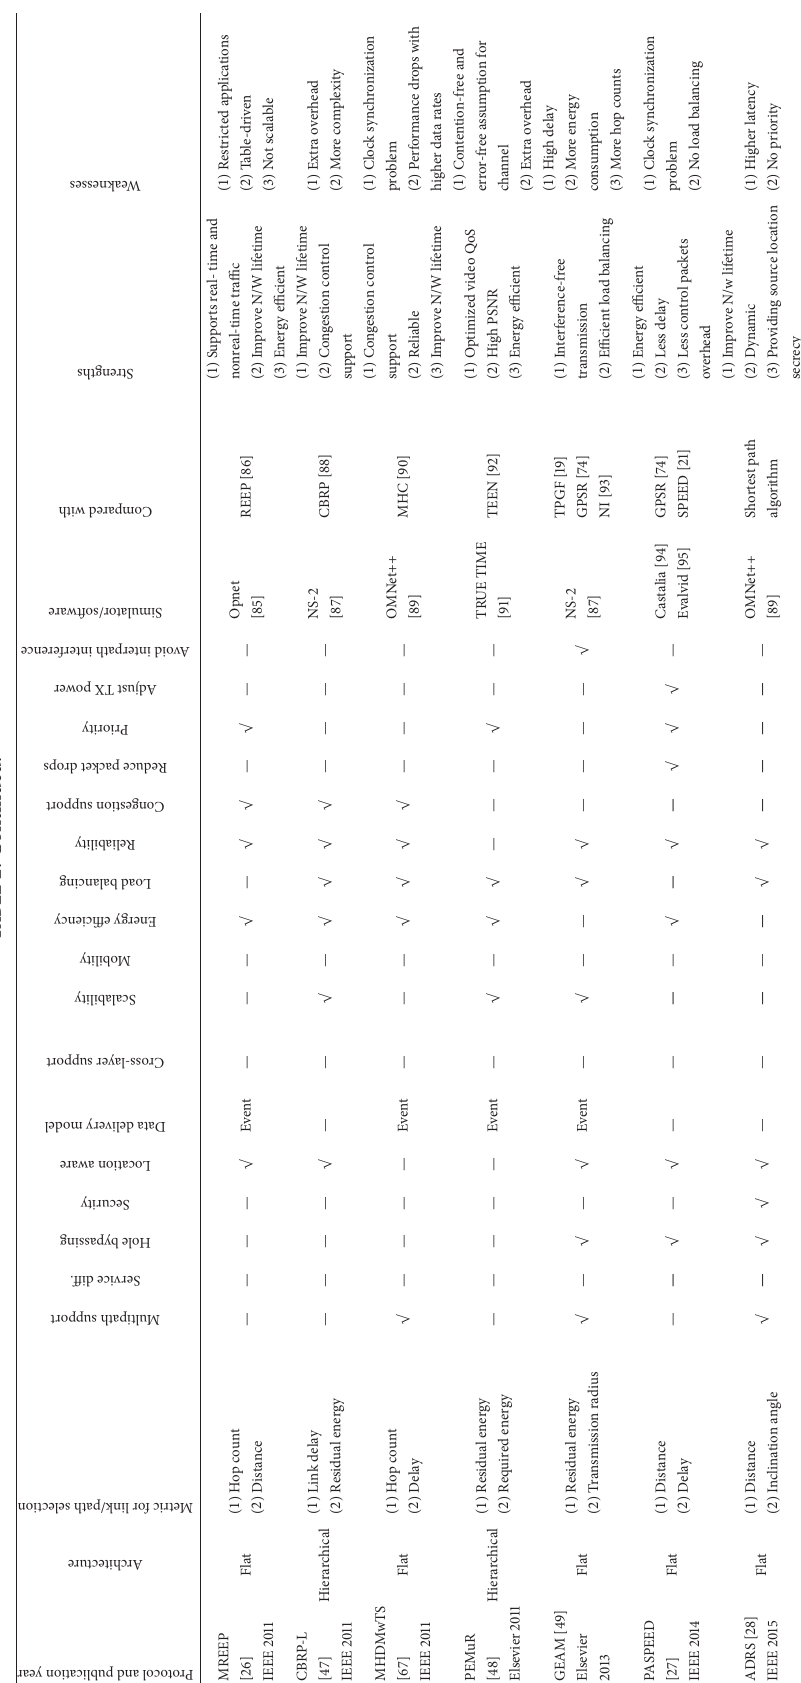
Protocolandpublicationyear